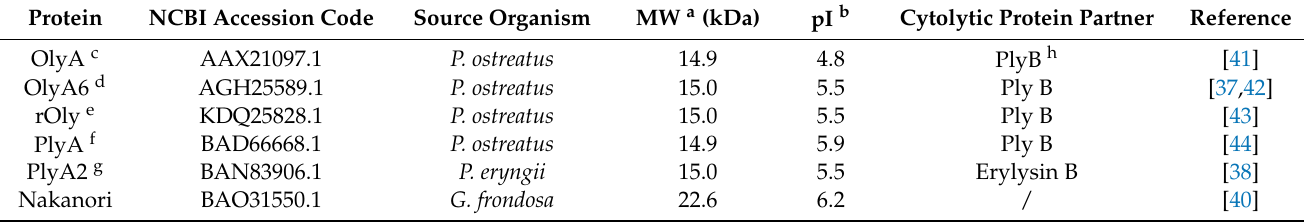
Table 1. Basic biochemical properties of the mushroom lipid raft binding proteins.